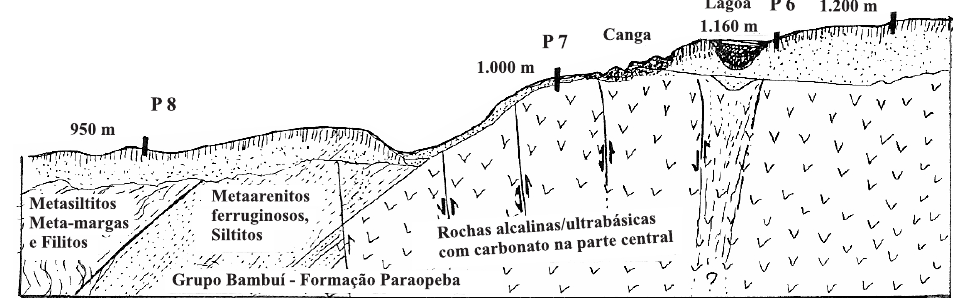
Figura 2. Perfil geológico esquemático da topolitossequência Patrocínio (T2) e posições dos respectivos